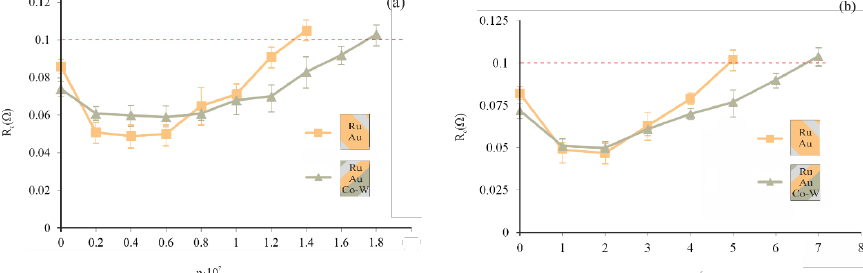
Figure 9. Temporal evaluation of R c -value in the course of the commutation tests for MKA-14 reed switches with Au – Ru and Au – (Co – W) – Ru: ( a ) low-power mode (50 mV, 5 μ A, 50 Hz), reed switches with Au–Ru and Au –(Co–W)–Ru: ( a ) low-power mode (50 mV, 5 µ A, 50 Hz), ( b ) mean-power mode (12 V, 0.25 A, 50 Hz). ( b ) mean-power mode (12 V, 0.25 A, 50